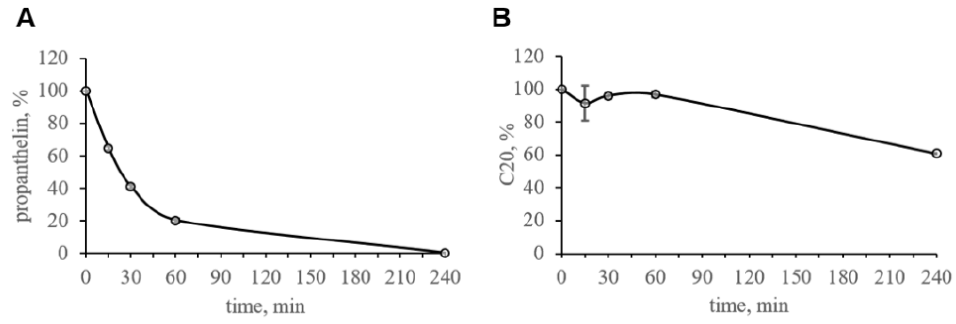
Figure 4. In vitro stability of C20 in pooled mouse plasma samples. ( A ) Control substance propanthe- line was used to confirm the activity of blood plasma enzymes. ( B ) Stability profile of C20. C20 is stable within 1 h in mouse plasma. Data are presented as mean ± SD. n (plasma samples) =